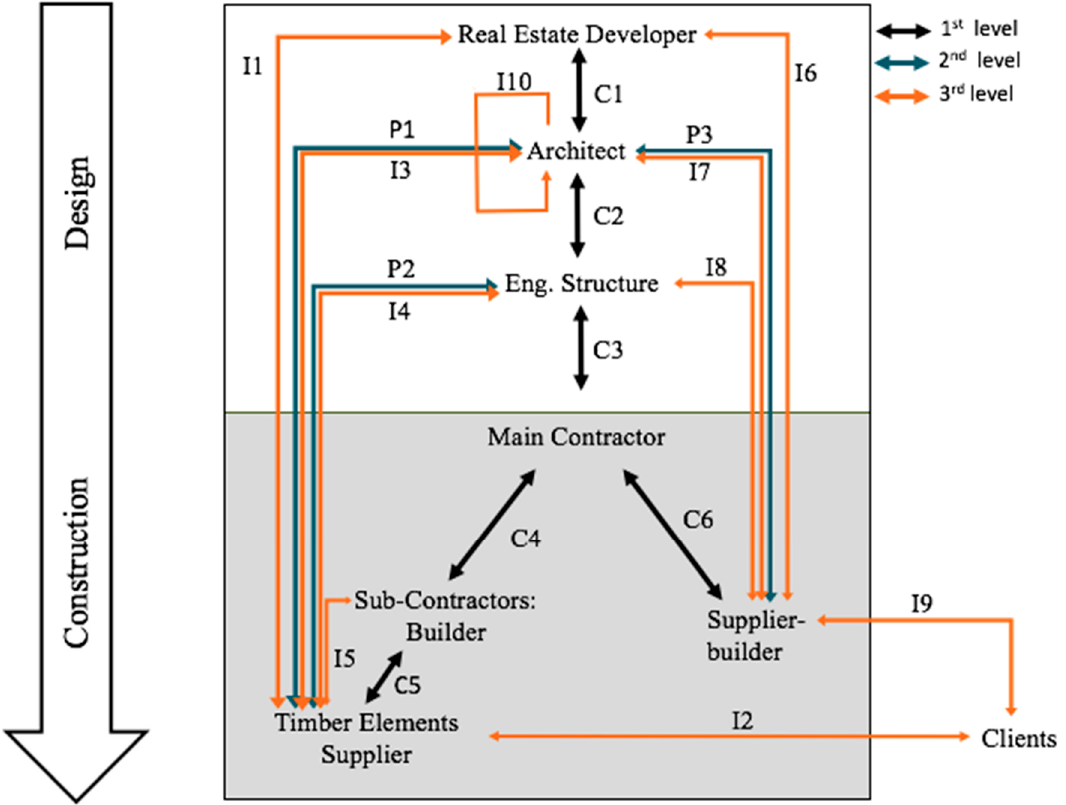
Figure 6. “Contractual (C),” “timber building project (P)” and “structural timber building industry development (I)” relationships involved in a structural timber building